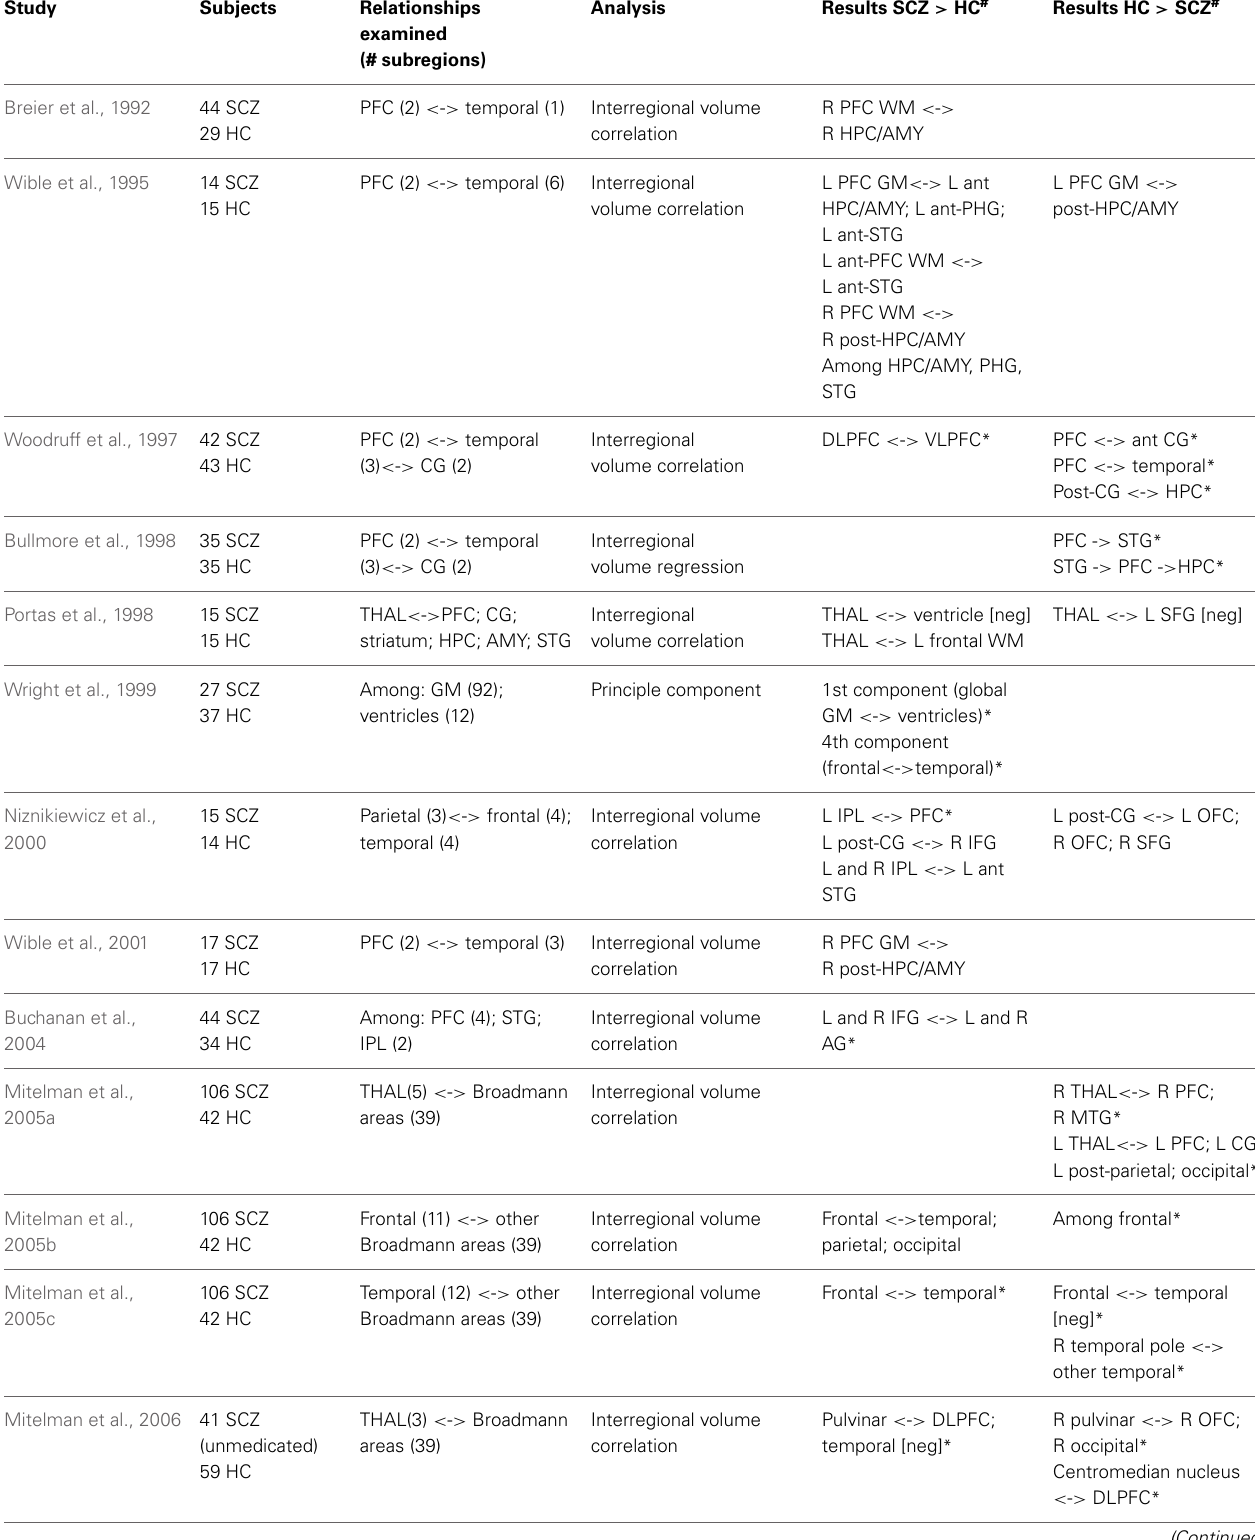
Table 3 | Structural co-variance comparisons in patients with